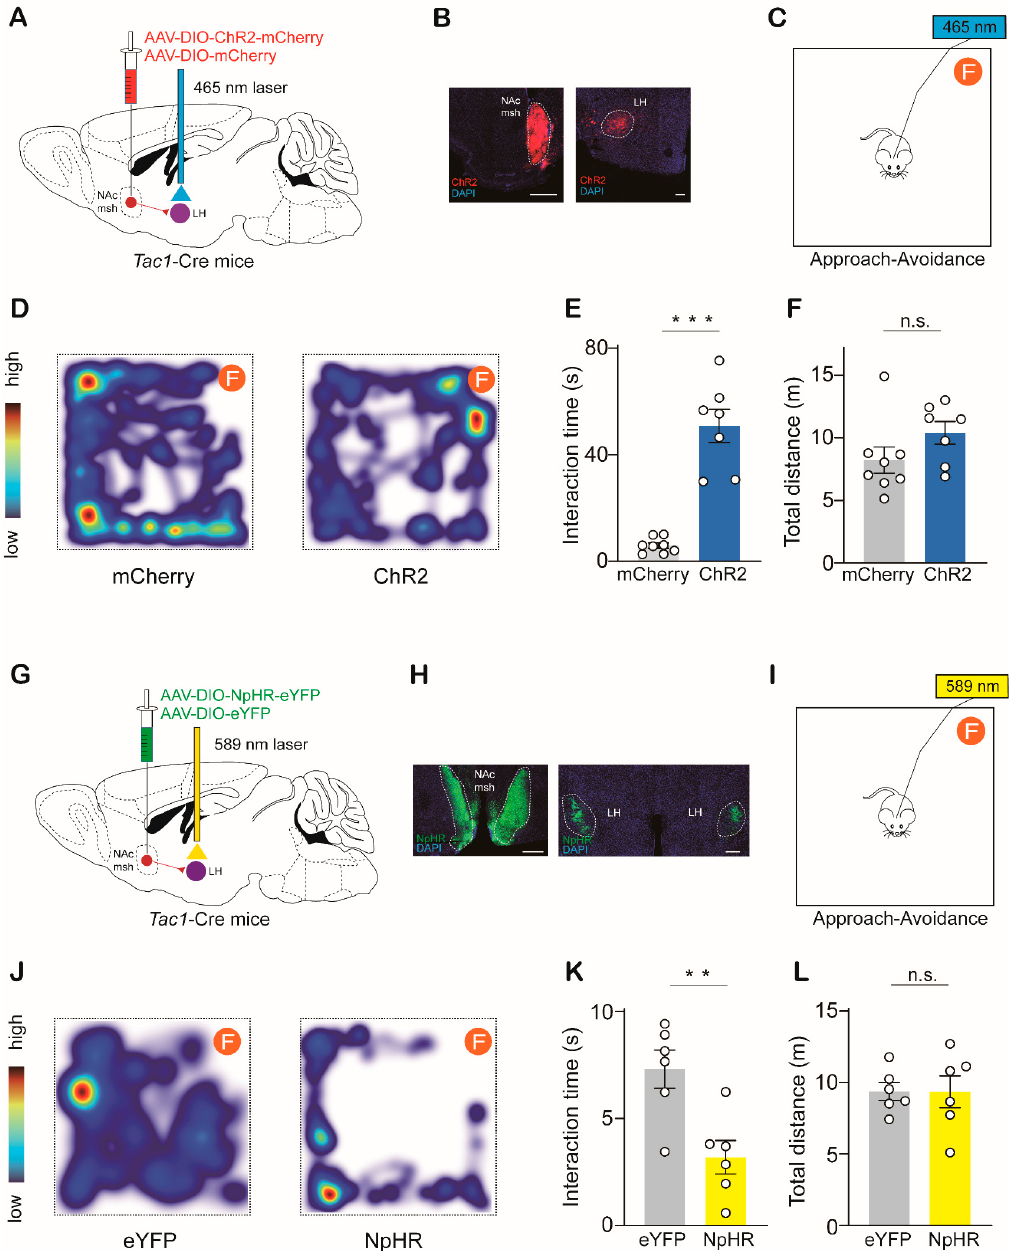
Figure 3. The NAc Tac1 -to-LH pathway regulates aversive behaviors in mice: ( A ) Schematic showing unilateral optogenetic stimulation of NAc Tac1 inputs to LH by ChR2. ( B ) Representative images of injection and projection sites. Scale bar: 200 µm. ( C ) Schematic of approach-avoidance assay (F: form, 5% formaldehyde solution). ( D ) Heat maps display time spent in different regions of the chamber (warmer colors indicate more time). ( E ) Mice expressing ChR2, but not mCherry, spent significantly more time interacting with formaldehyde with 20 Hz optical stimulation (two-tailed paired t -test, t 13 = 5.885, p < 0.0001). ( F ) Mean total distance traveled in the chamber (two-tailed paired t -test, t 13 = 1.566, p = 0.1415). mCherry: N = 8; ChR2: N = 7. ( G ) Schematic showing bilateral optogenetic inhibition of NAc Tac1 inputs to LH by NpHR. ( H ) Representative images of injection and projection sites. Scale bar: 200 µm. ( I ) Schematic of approach-avoidance assay (F: form, 5% formal- dehyde solution). ( J ) Heat maps display time spent in different regions of the chamber (warmer